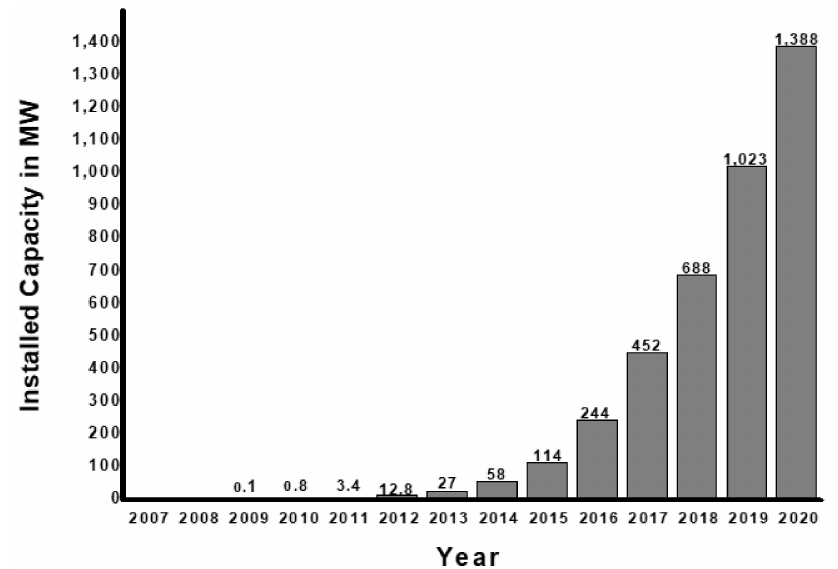
Figure 2. Evolution of installed solar power capacity in Mexico in MW